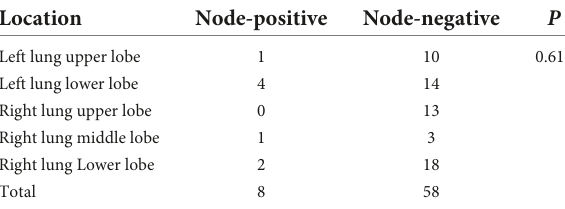
TABLE 3 Association between NTBL/NTBS metastasis and tumor primary site. Location